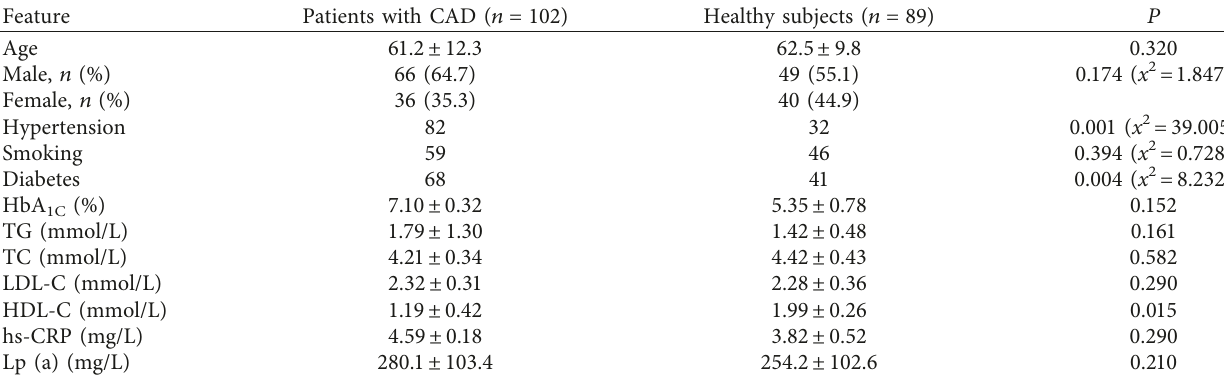
Table 1: Comparison of clinical pathological features between patients with CAD and healthy subjects.